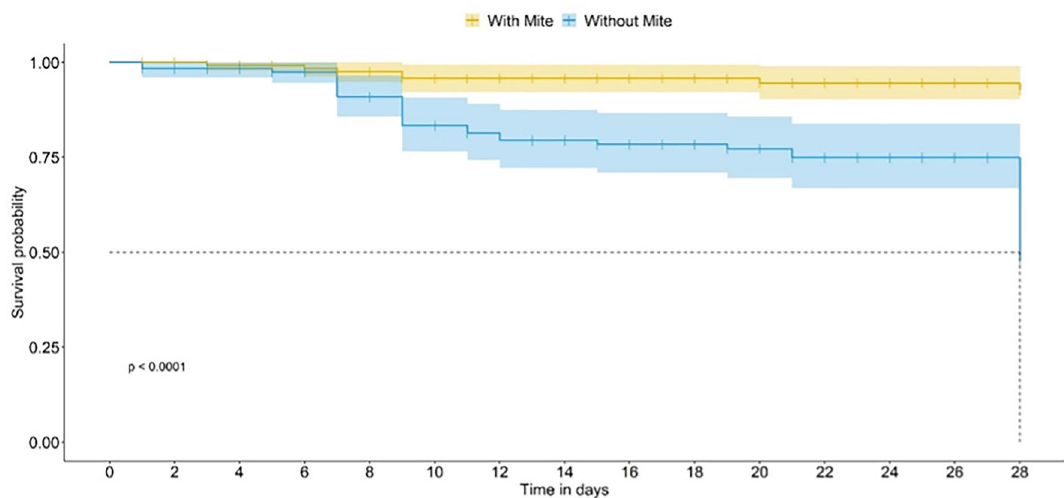
Figure 2. Scaptotrigona postica survivorship in the presence (with mites) and in the absence (without mites) in the control bioassay. The dashed line indicates the estimated median life span for bees in the presence and absence of the mite.